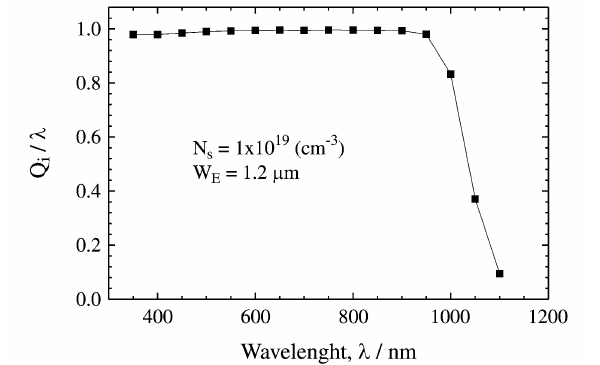
Figure 4. Solar cell internal quantum efficiency as function of wave- length. The emitter is admitted to be passivated with a surface doping level N s = 1x10 19 (cm -3 ) and W E = 1.2 ( µ m).